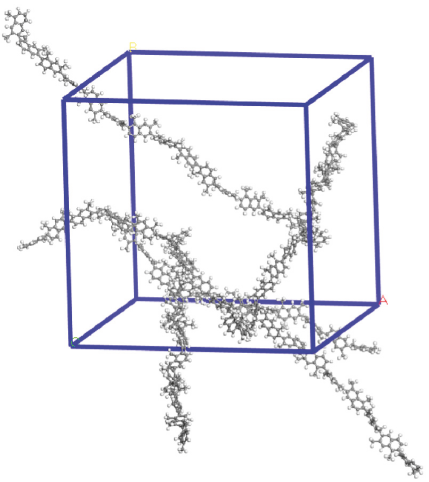
Figure 3: Initial model of colloid at the density of 0.1.